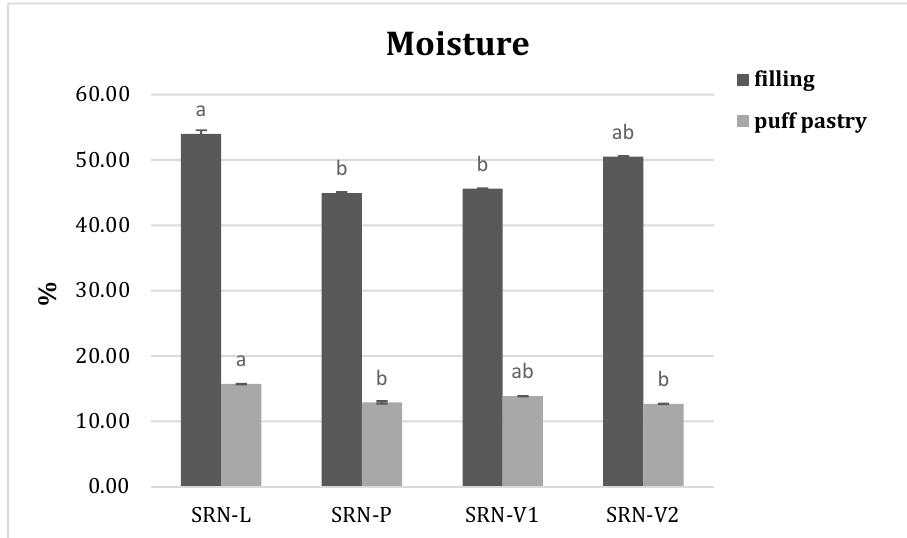
Figure 3. Moisture contents of the filling and puff pastry in baked “ sfogliatella riccia napoletana ” prepared with the different fat blends L, P, V1, and V2. a,b: Different letters indicate statistically significant differences ( p ≤